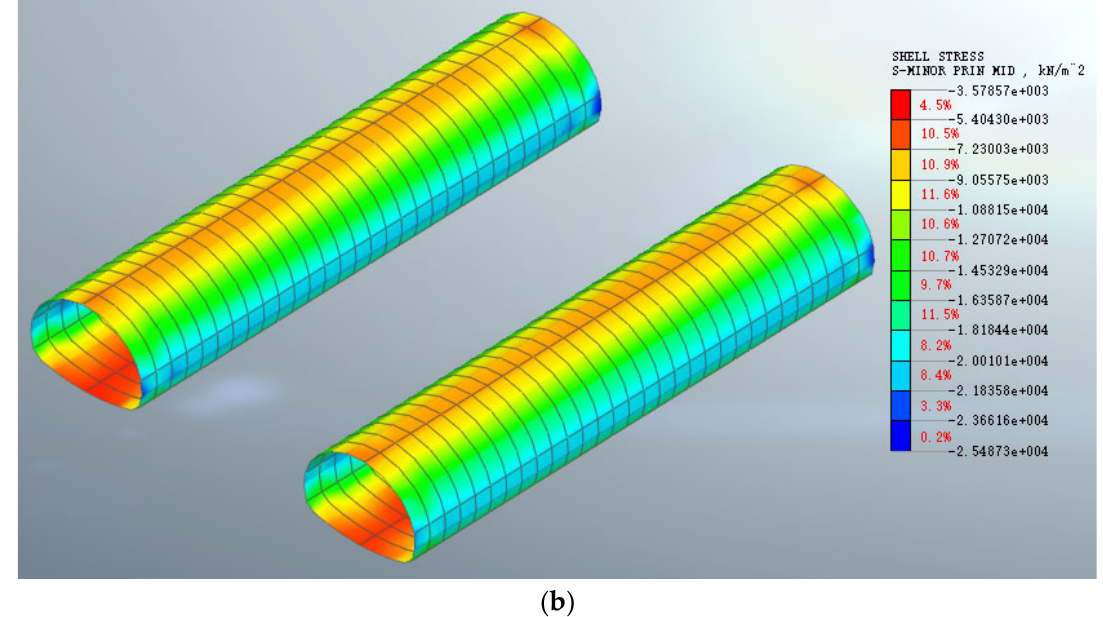
Figure 8. The initial support maximum and minimum stress clouds for the CRD method. ( a ) Maximum principal stress by the CRD method. ( b ) Minimum principal stress by the CRD